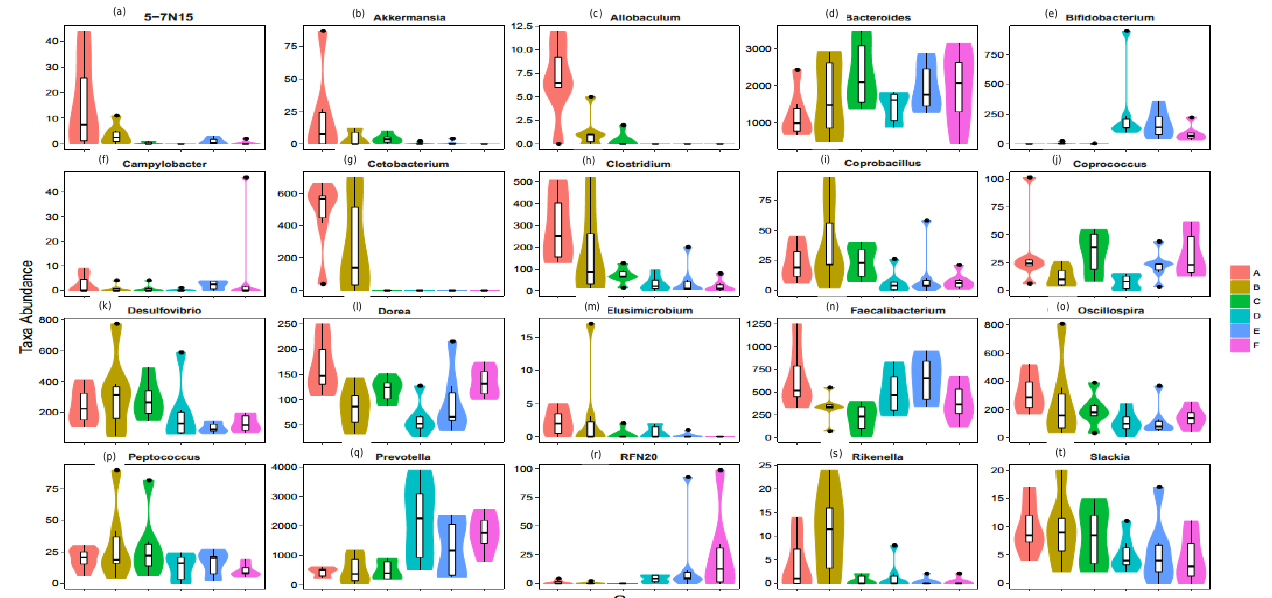
Figure 9. Relative abundances of ( a ) 5-7N15; ( b ) Akkermansia; ( c ) Allobaculum; ( d ) Bacteroides; ( e ) Bifidobacterium; ( f ) Camplylobacter; ( g ) Cetobaccccterium; ( h ) Clostridum; ( i ) Coprobacillus; ( j ) Coprococcus; (k) Desulfovibrio; ( l ) Dorea; ( m ) Elusimicrobium; ( n ) Faecalibacterium; ( o ) Oscillospira; ( p ) Peptococcus; ( q ) Prevotella; ( r ) RFNzo; ( s ) Riskenella; ( t ) Slackia. Data are shown as the means ± SEM. Each color represents the relative abundance of each diet group (A, B, C, D, E, F).